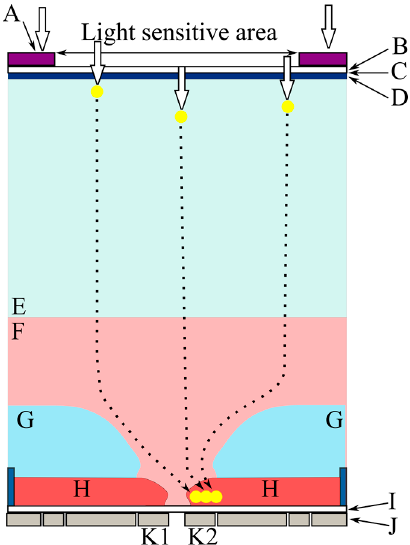
Figure 2. A cross-section structure of a pixel of a backside-illuminated (BSI) image sensor and trajectories of signal electrons. A: light shield; B: oxide; C: interface between the backside oxide layer and the silicon layer; D: backside hole accumulation layer; E: p − layer, F: n − layer; G: p-well; H: memory and circuit areas; I: oxide; J: electrodes and wires; K: collection gates.